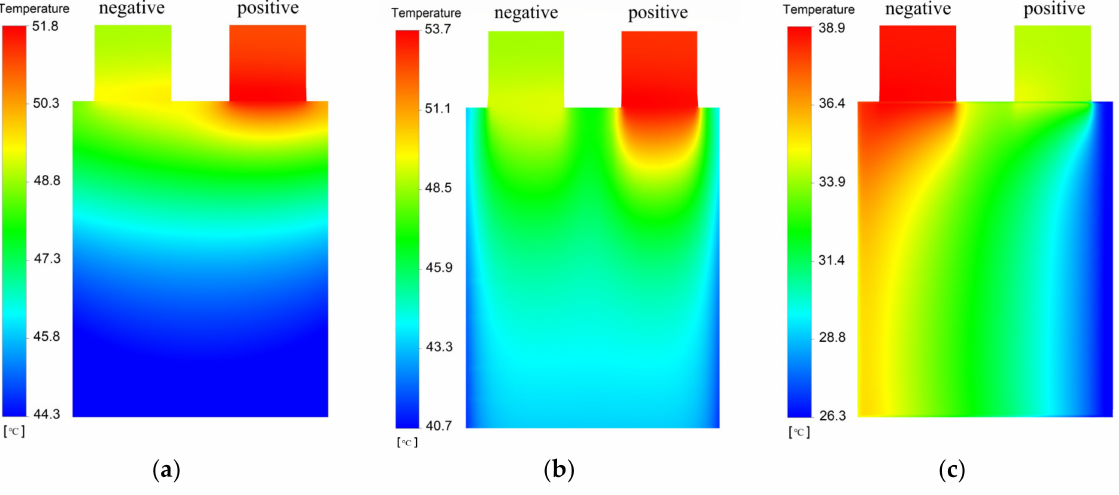
Figure 9. Temperature distributions on the cell at the end of 3 C discharge: ( a ) natural cooling; ( b ) immersion cooling at 0 mm/s; ( c ) immersion cooling at 1